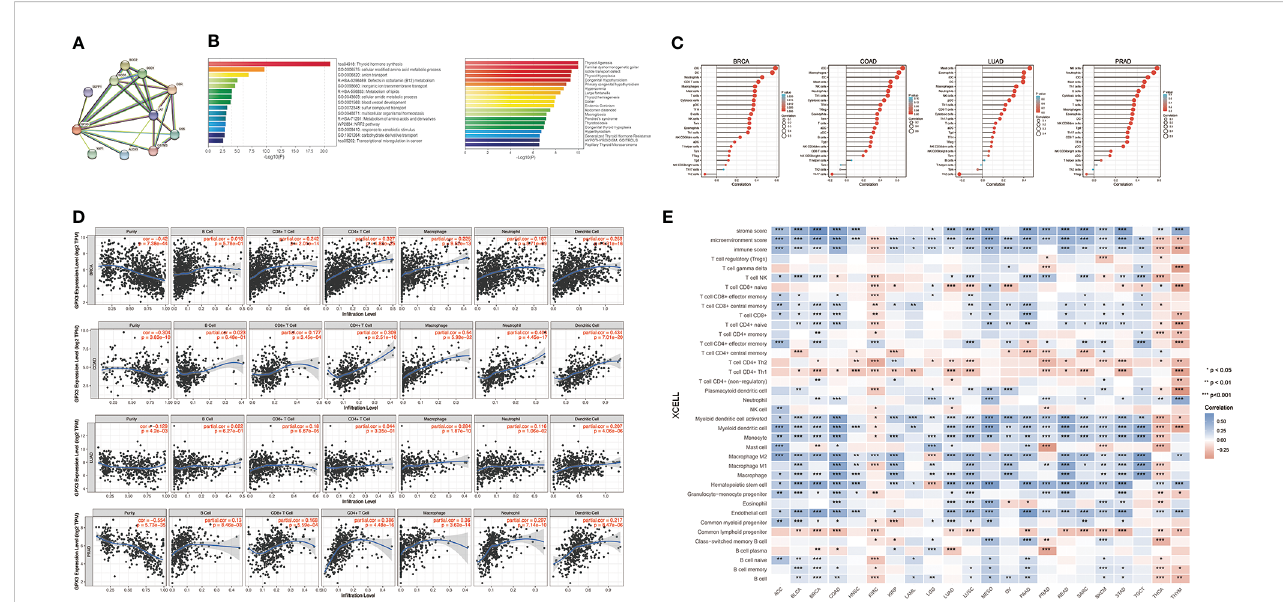
FIGURE 4 The potential function of GPX3 and effects on immune in fl itration in cancers. (A) The GPX3-binding PPI analysis. (B) The GO and KEGG analysis of GPX3 and GPX3-related partners. (C) Correlation analysis between GPX3 expression and immune cells in scatter plots. (D) Correlation analysis between GPX3 expression and immune cells in stem-and-leaf display. (E) The immune score and cells analysis of GPX3 in